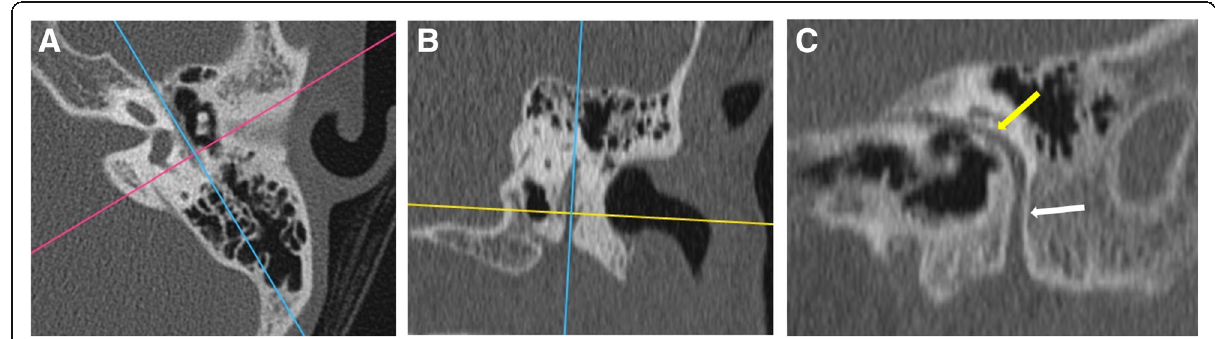
Fig. 10 Axial ( a ) and coronal ( b ) reference CT images show plane of reconstruction (blue line) to form the double oblique sagittal ( c ) image showing normal anatomy of tympanic (yellow arrow) and mastoid segments (white arrow) of the facial nerve